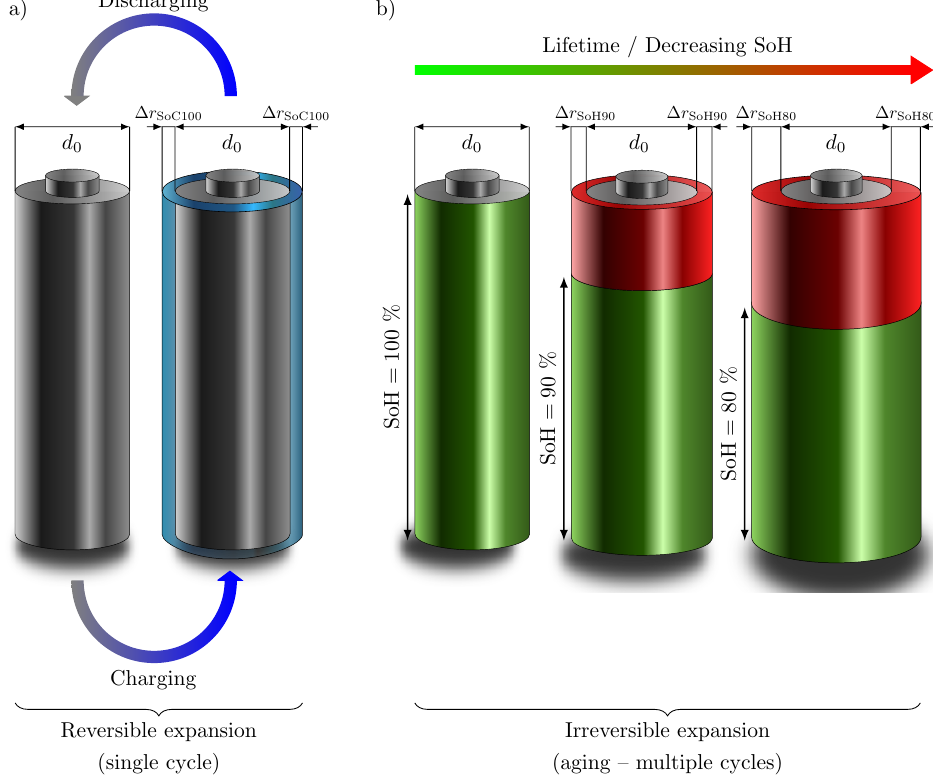
Figure 1. Theoretical schematic representation of ( a ) reversible and ( b ) irreversible cell thickness growth ( ∆ r SoC ) compared to the initial diameter ( d 0 ). ( a ) As a result of the volume expansion of graphite with increasing lithiation, the radius of the battery cell increases over every single cycle. The battery cell returns to its original shape when discharged. ( b ) Due to SEI layer thickness growth, defects in graphite, and pressure rise due to side reactions over the lifetime of a cylindrical Li-ion cell, the radius of the battery cell increases irreversibly by ∆ r SoH with decreasing SoH (green) and increasing irreversible aging (red) until the end-of-life (EoL) of the